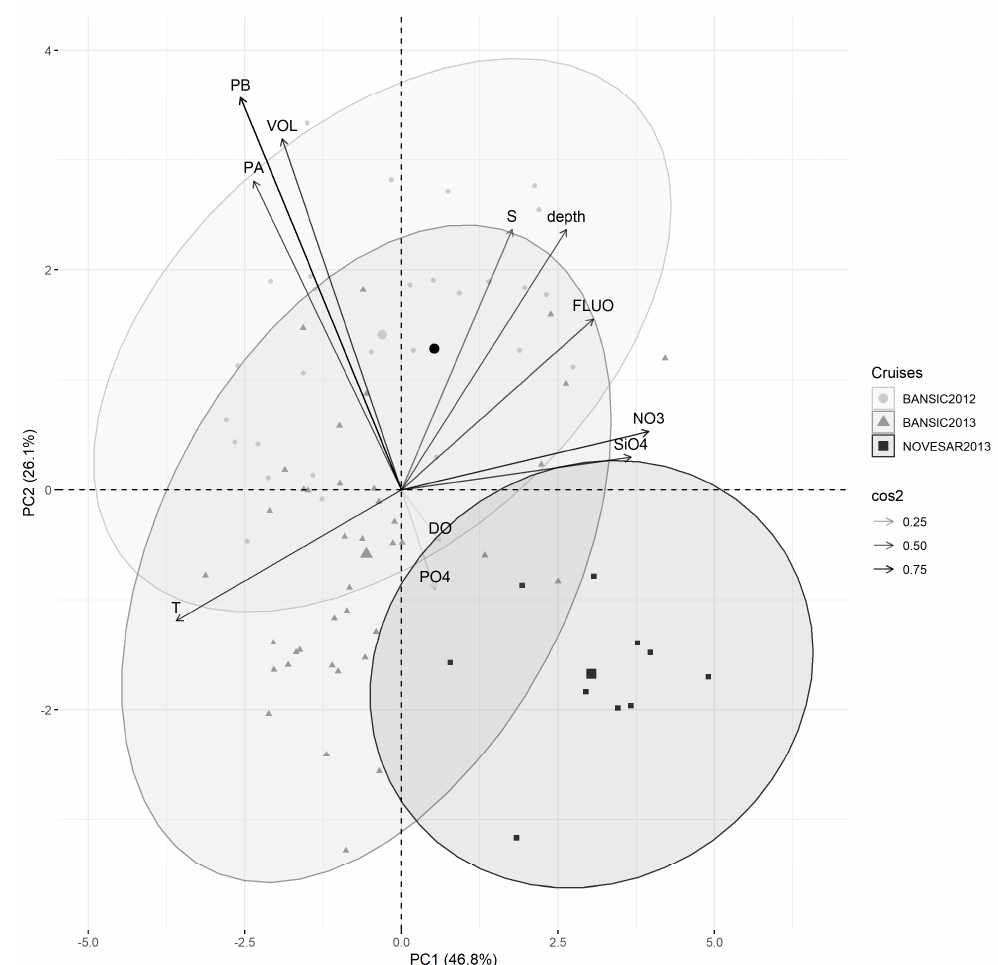
Figure 4. PCA ordination biplots for the microbiological and environmental variables analyzed in BANSIC 2012, NOVESAR 2013 and BANSIC 2013. The percentage of variance explained by each represents the squared loadings for variables and shows the importance of a principal component for a given observation. Filled circles represent samples collected from BANSIC 2012 cruise; filled triangles represent the samples collected from BANSIC 2013 cruise; filled squares represent the samples collected from NOVESAR 2013 cruise.